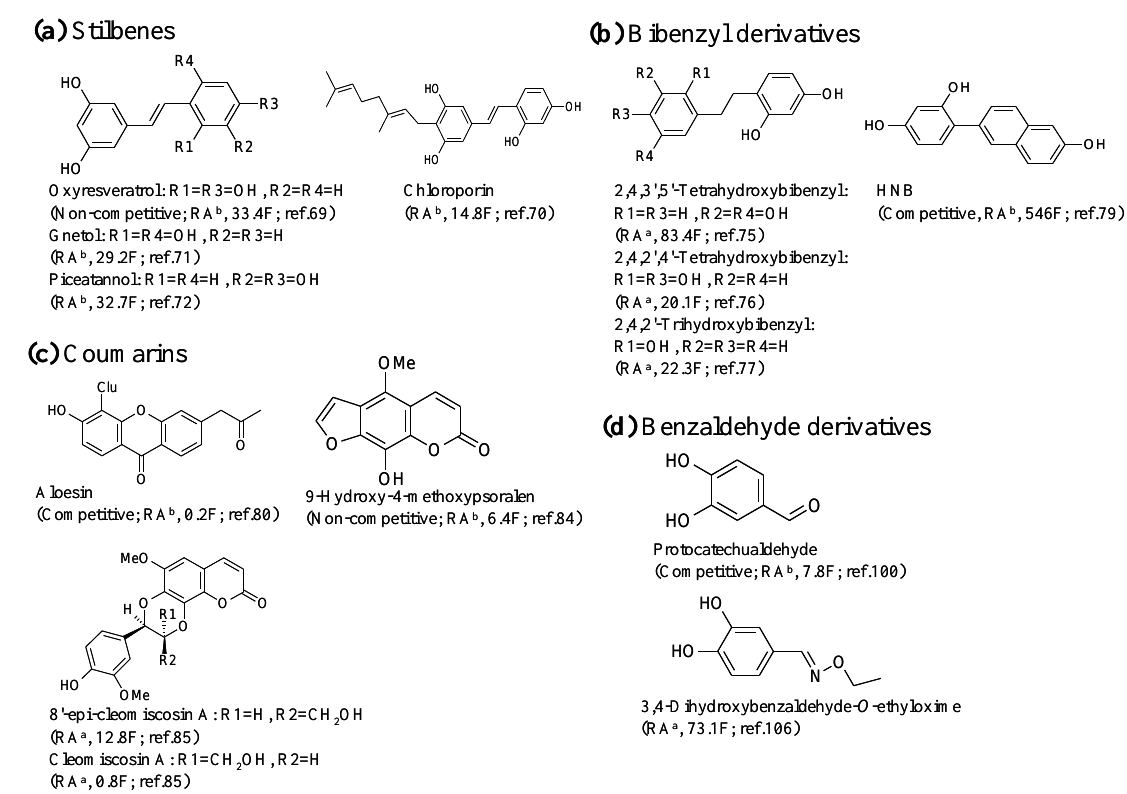
Figure 4. Chemical structures of selected tyrosinase inhibitors belonging to stilbenes (a), bibenzyl derivatives (b), coumarins (c), and benzaldehyde derivatives (d). RA a and RA b have the same meanings as those of Figure